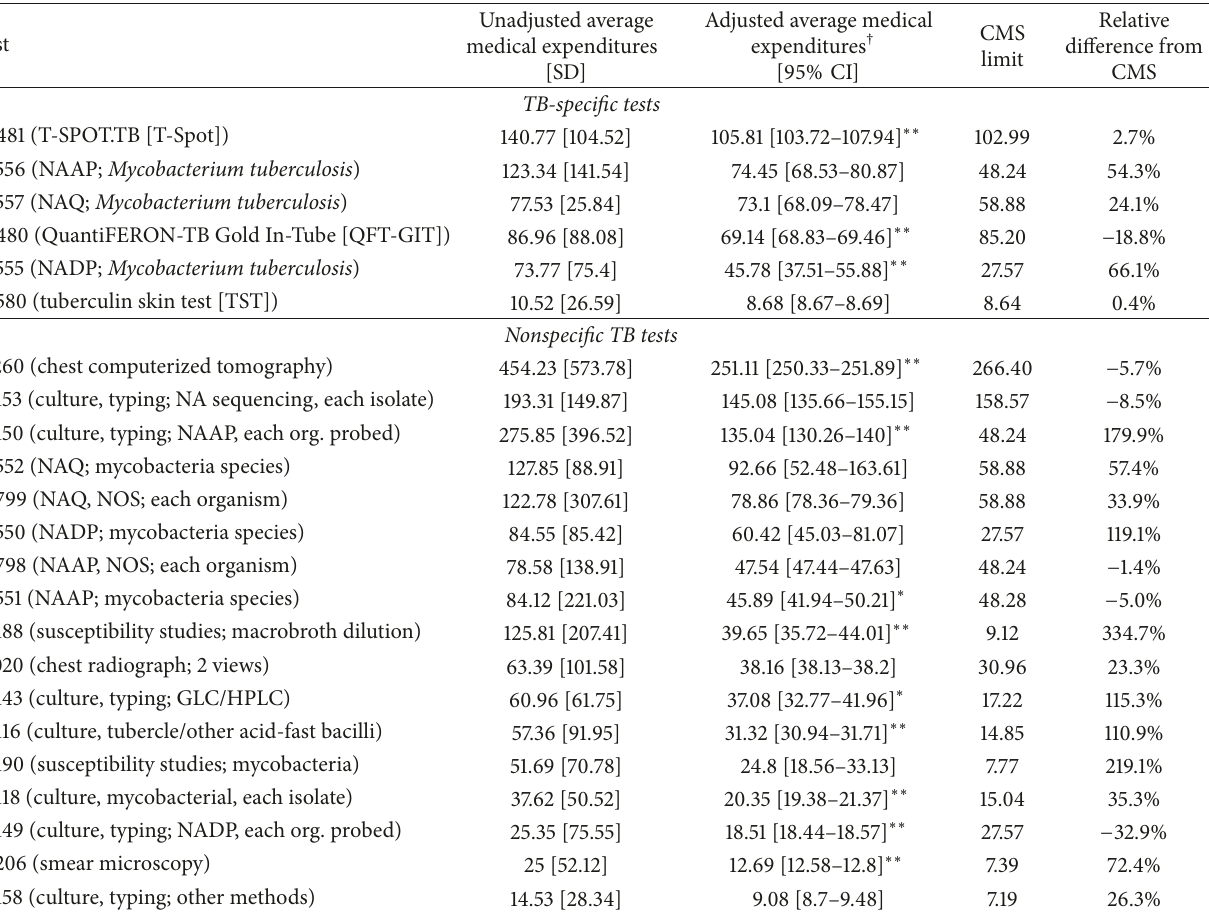
Table 3: Summary results showing the unadjusted and adjusted average medical expenditures for all the tests (2013 United States dollars).